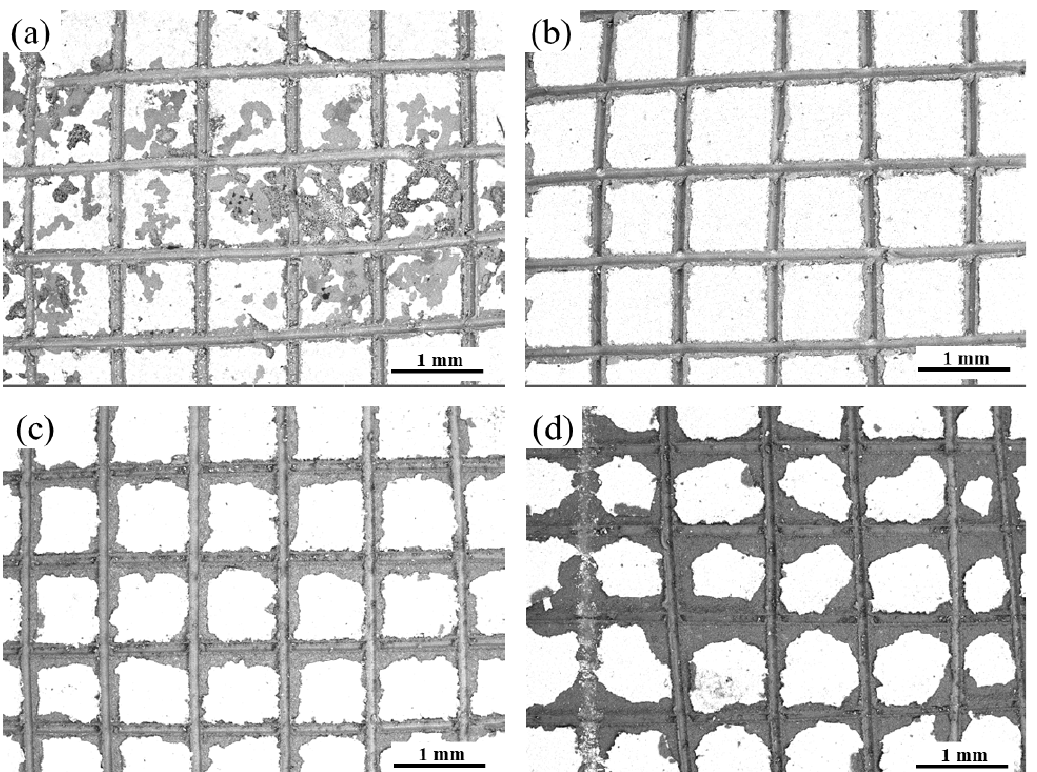
Coatings 2021 , 11 , x FOR PEER REVIEW